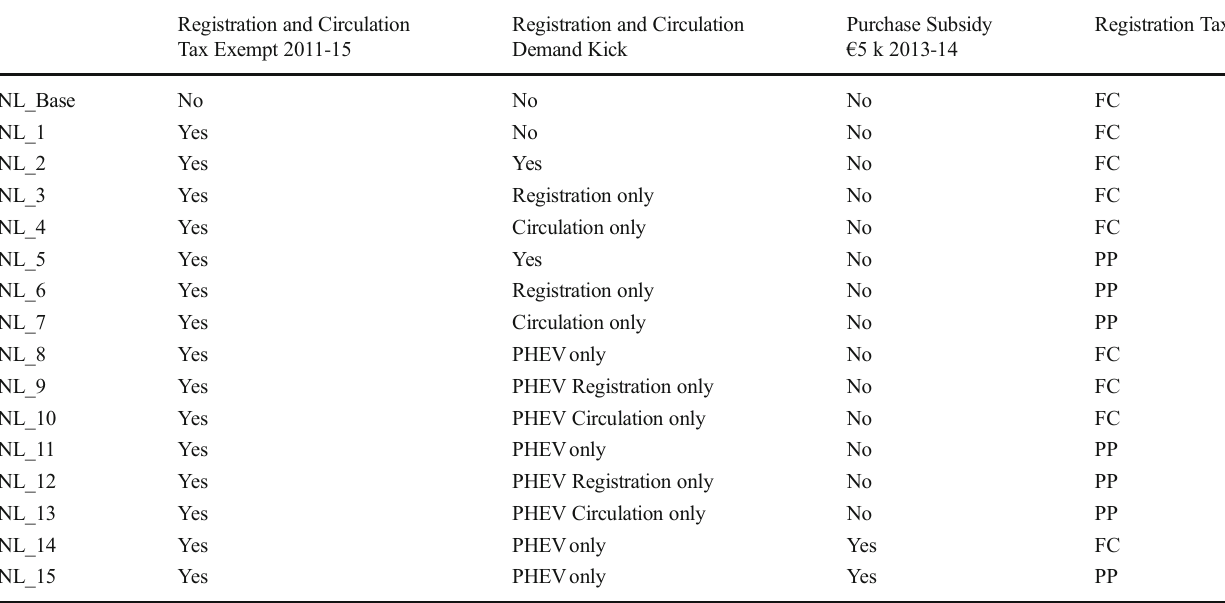
Netherlands Scenario